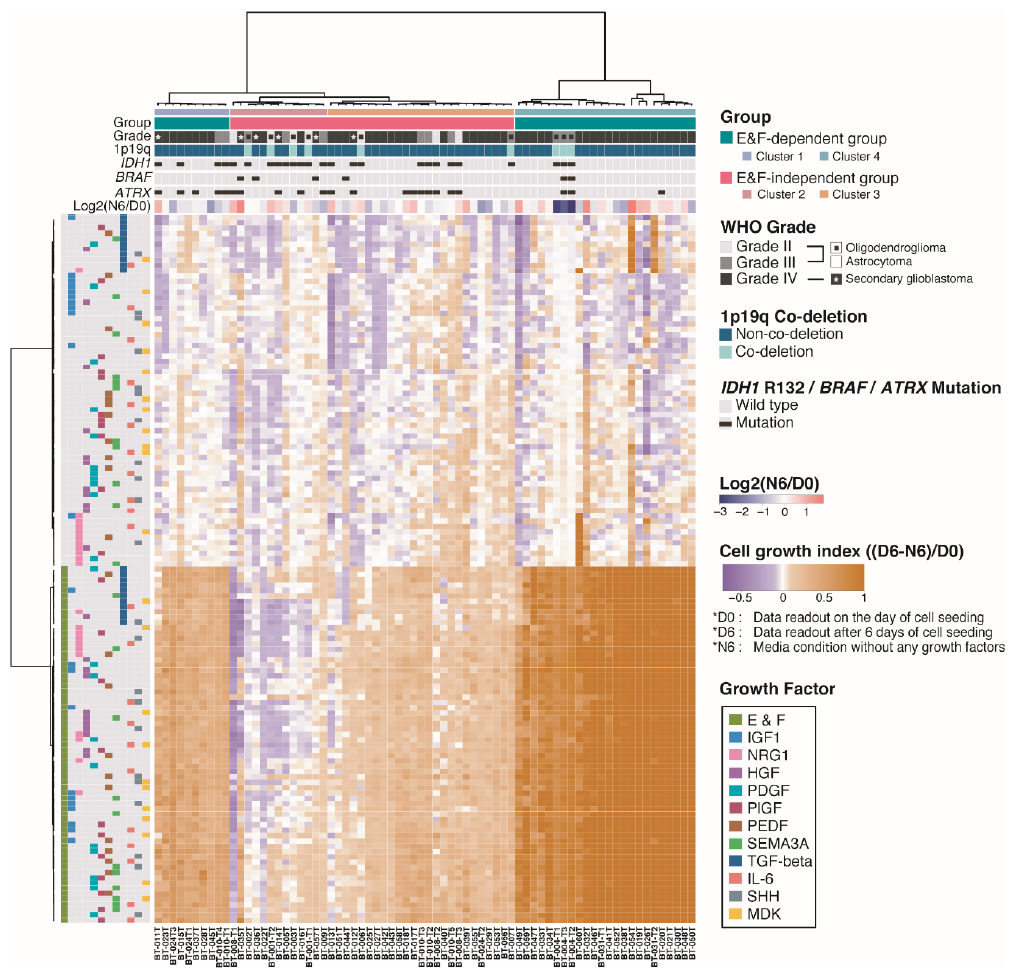
Figure 3. Unsupervised clustering of cell growth indices evaluated by GFSCAN in 72 DIGs. The unsupervised clustering revealed that DIGs are categorized according to their E&F dependencies.